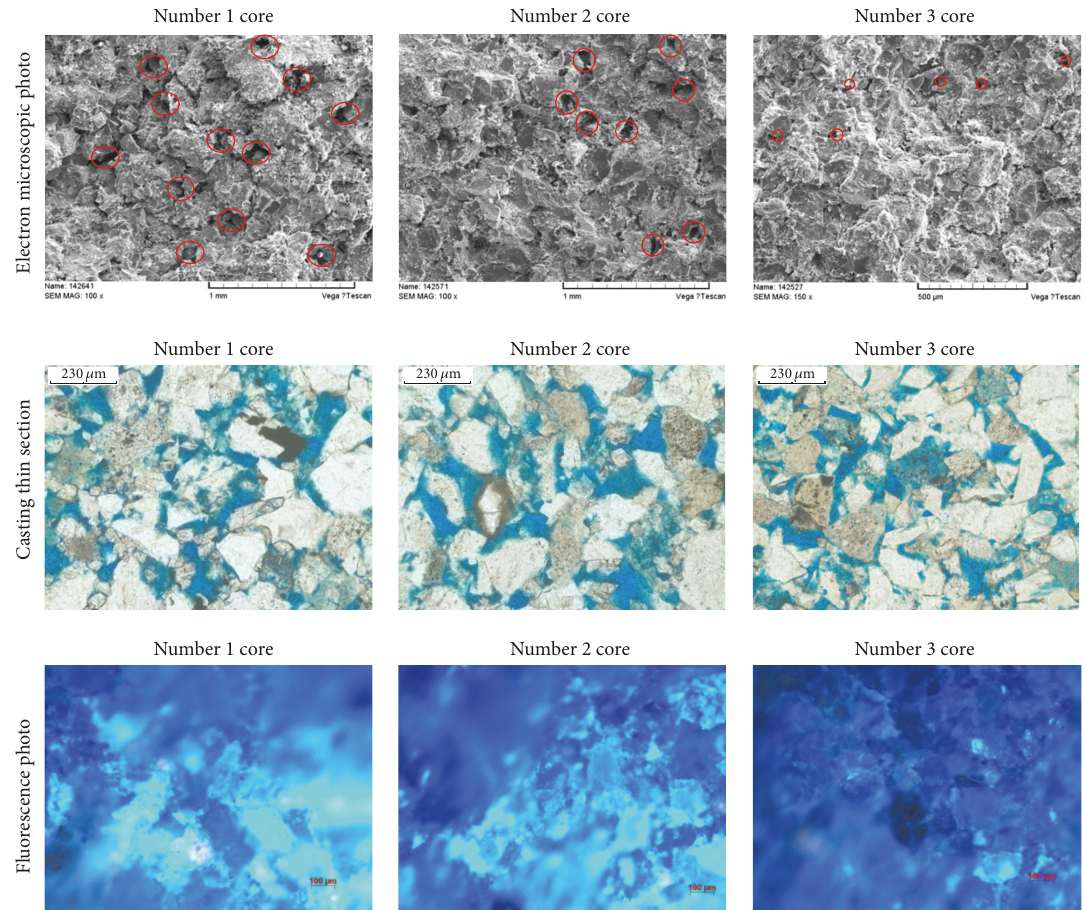
Figure 2: Microcosmic pore characteristics of different depths of